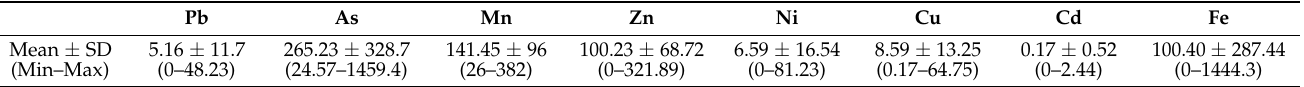
Table 1. Trace elements concentrations (mg Kg − 1 ) in muscle samples of the lesser spotted dogfish. Data are shown as the average value, the standard deviation (sd), and the range (minimum–maximum).